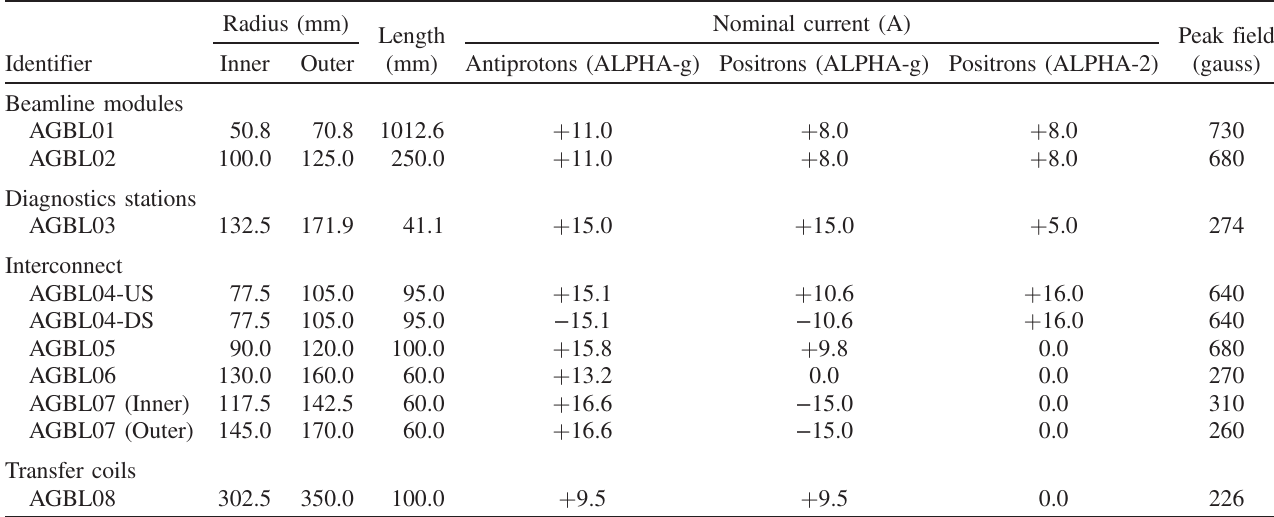
TABLE II. Design specifications for the ALPHA beamline magnets. Nominal operating currents are given for each of the three main beamline configurations, used to transfer ¯ p bunches to the ALPHA-g experiment or e þ bunches to either the ALPHA-2 or ALPHA-g experiment. Peak magnetic fields were calculated for the ¯ p beamline configuration. The direction of current in each magnet is defined relative to its polarity in the ¯ p beamline configuration, which ensures continuity of the magnetic field between the CT and ALPHA-g.